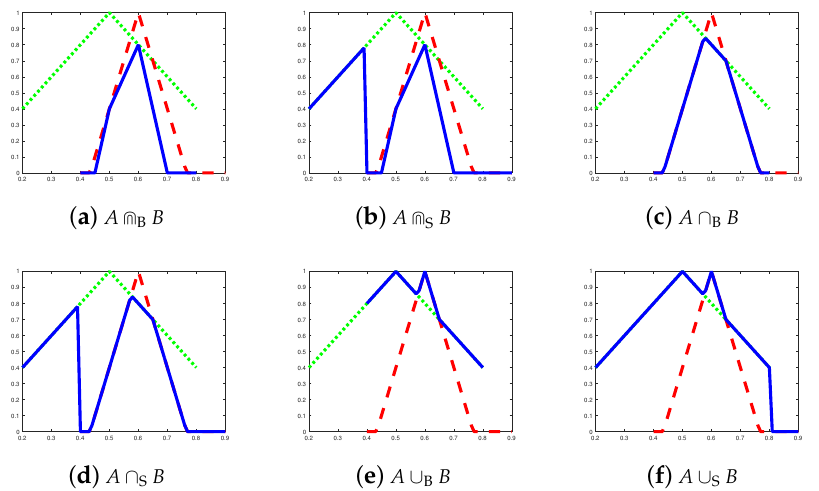
Figure 3. Bochvar and Soboci´nski operations depicted by the solid line with partial fuzzy sets A = ( (cid:104) 0.2,0.8 (cid:105) ,dotted line ) and B = ( (cid:104) 0.4,0.9 (cid:105) ,dashed line ) on the universe U = (cid:104) 0,1 (cid:105)